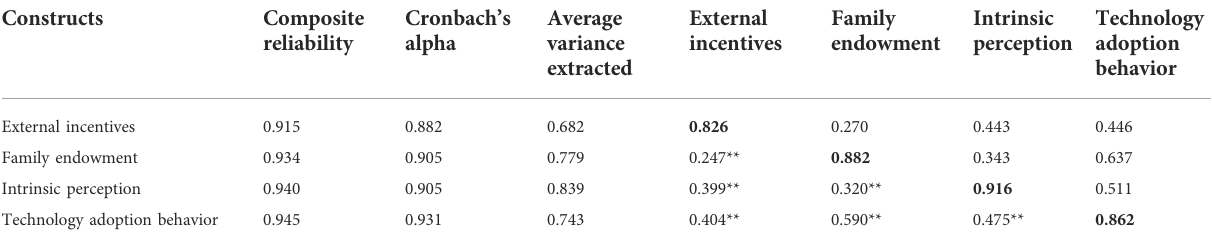
TABLE 2 Construct consistency, reliability, convergent and discriminant validity squared value of the AVE reported on the main diagonal of the correlation matrix. Constructs